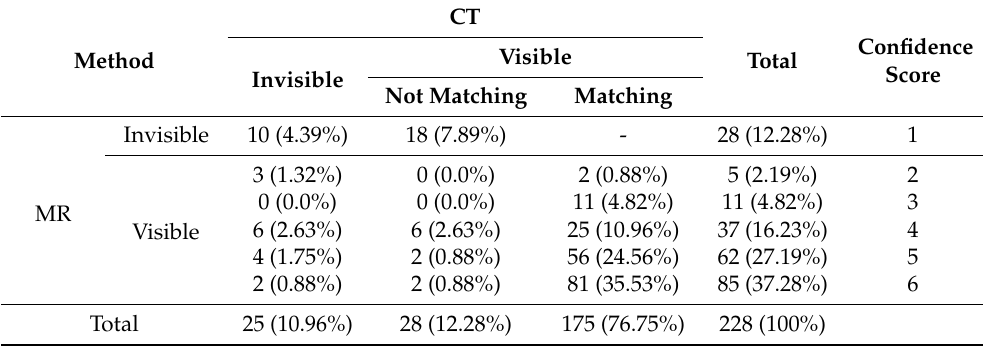
Table 3. Frequency summary table of the carotid bodies eligible for ROC